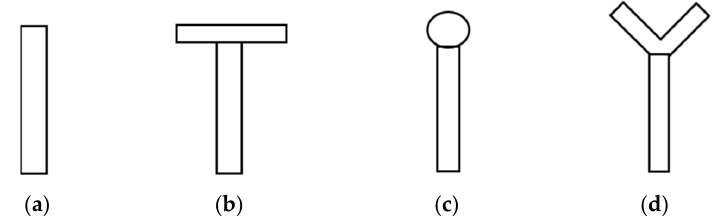
Figure 2. Different shapes of commonly used noise barrier: ( a ) rectangular; ( b ) T-shaped; ( c ) cylindrical; ( d ) Y-shaped (branched).